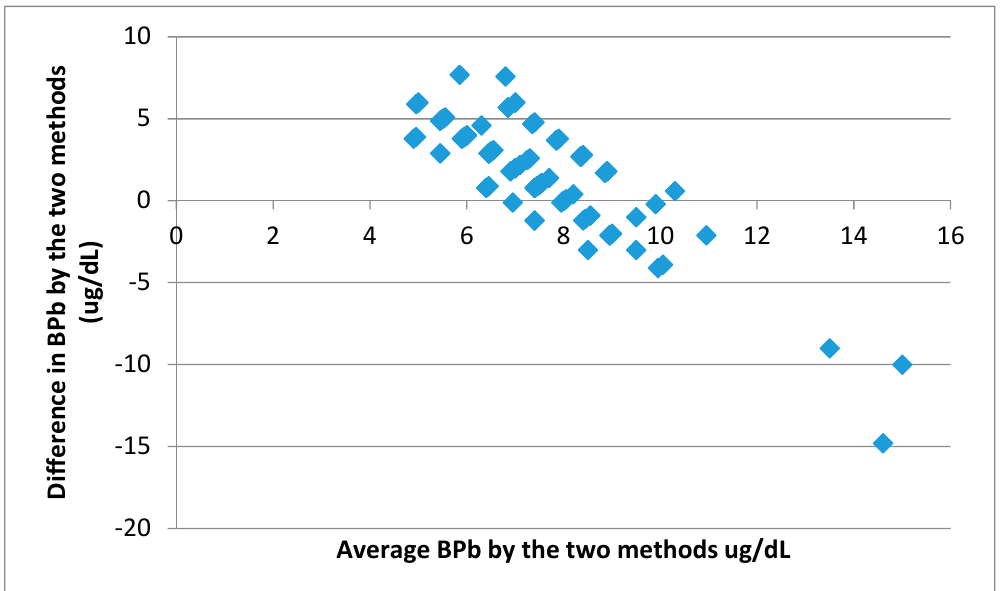
Figure 4. A plot of the average of the measured and predicted BPb against the differences between predicted and measured BPb values (for 31% food Pb bioavailability and a default 30% soil Pb bioavailability).